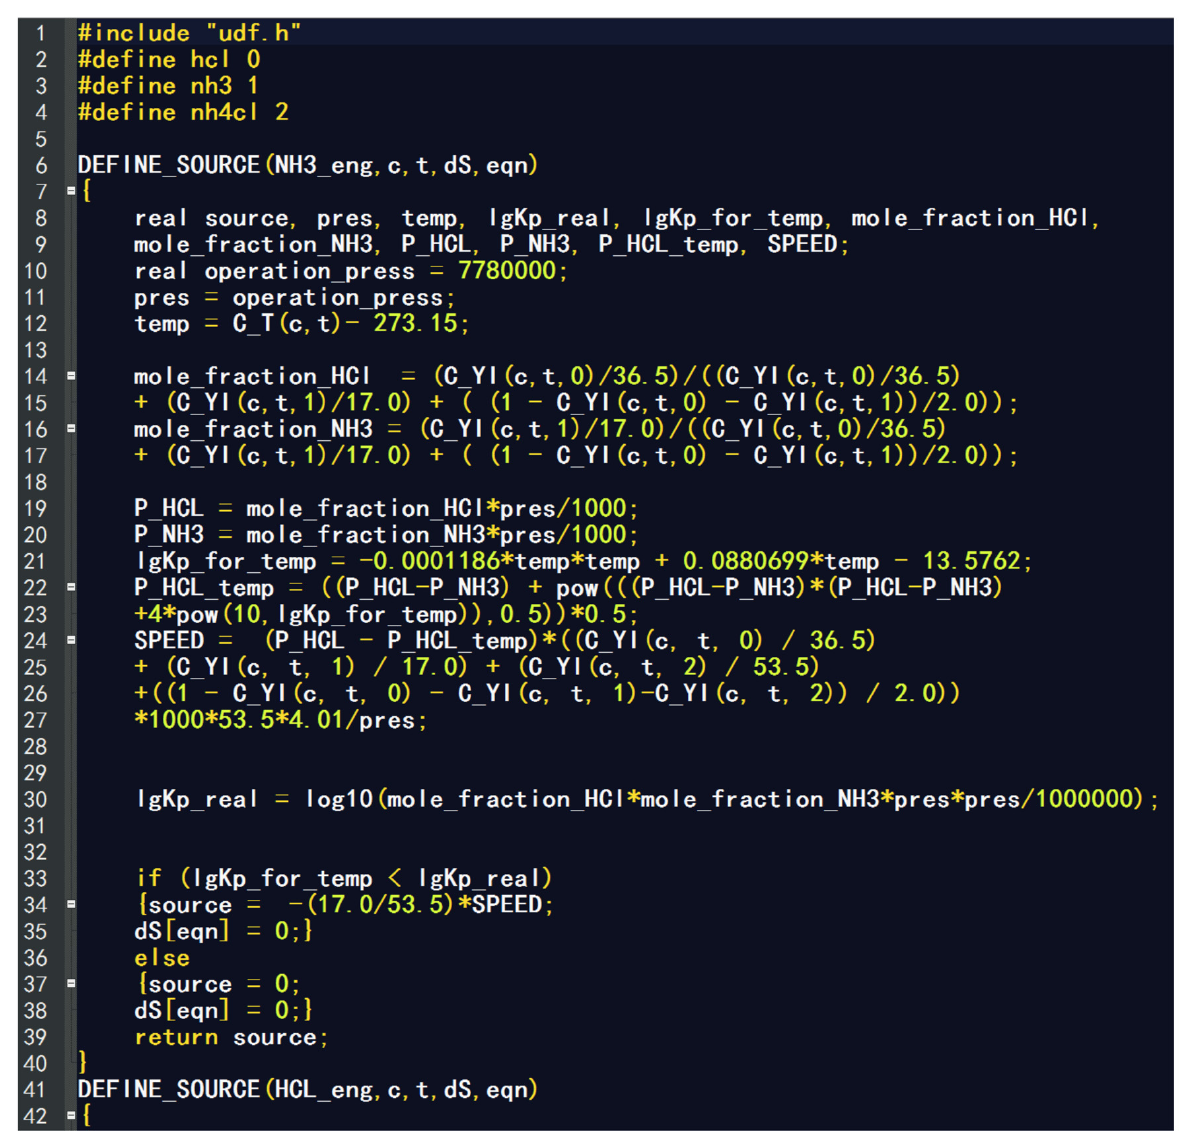
Figure 9. The core code of user-defined